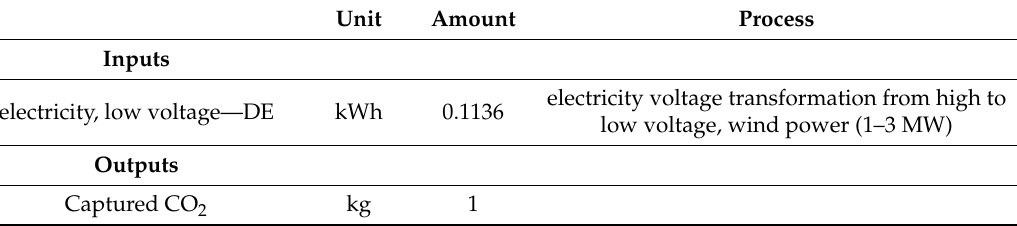
Table A13. Capturing CO 2 from